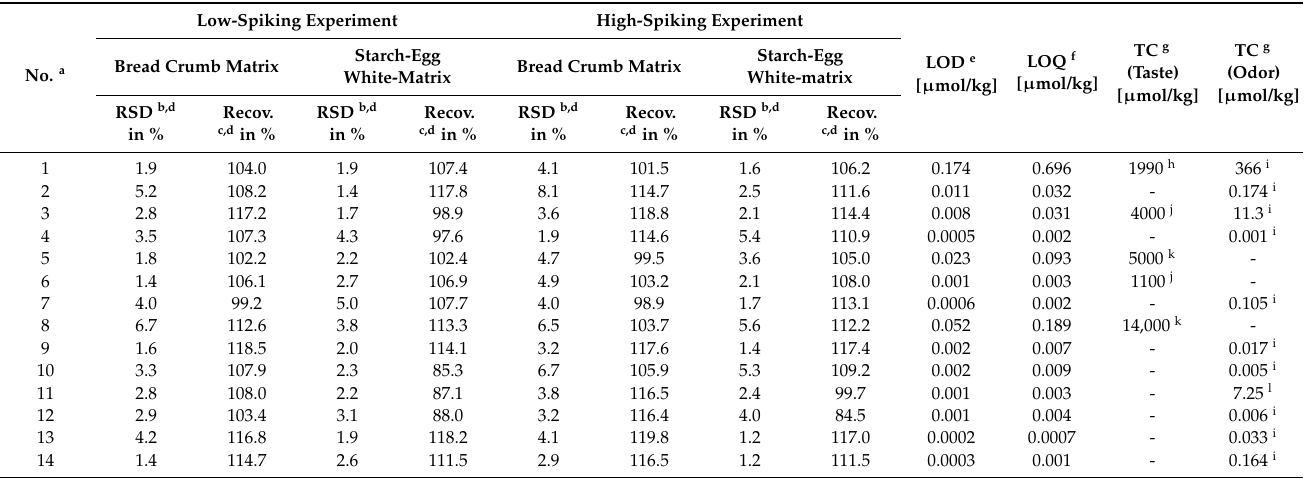
Table 5. Validation experiments for the quantitation of 3-NPH-derivatized key taste and aroma compounds in bread